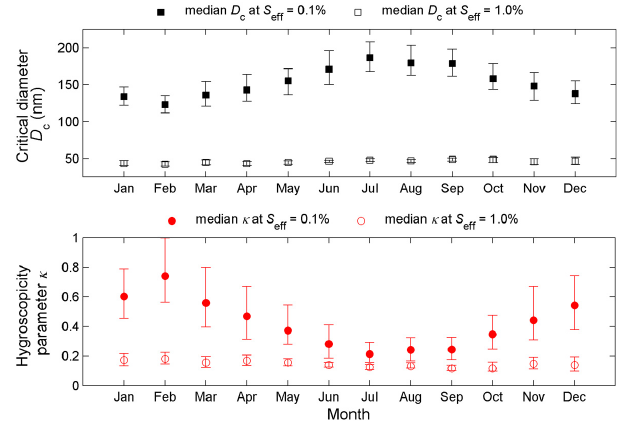
Fig. 8. Monthly median D c (top) and κ (bottom), shown for two lev- els of supersaturation S eff . Error bars are 25th and 75th